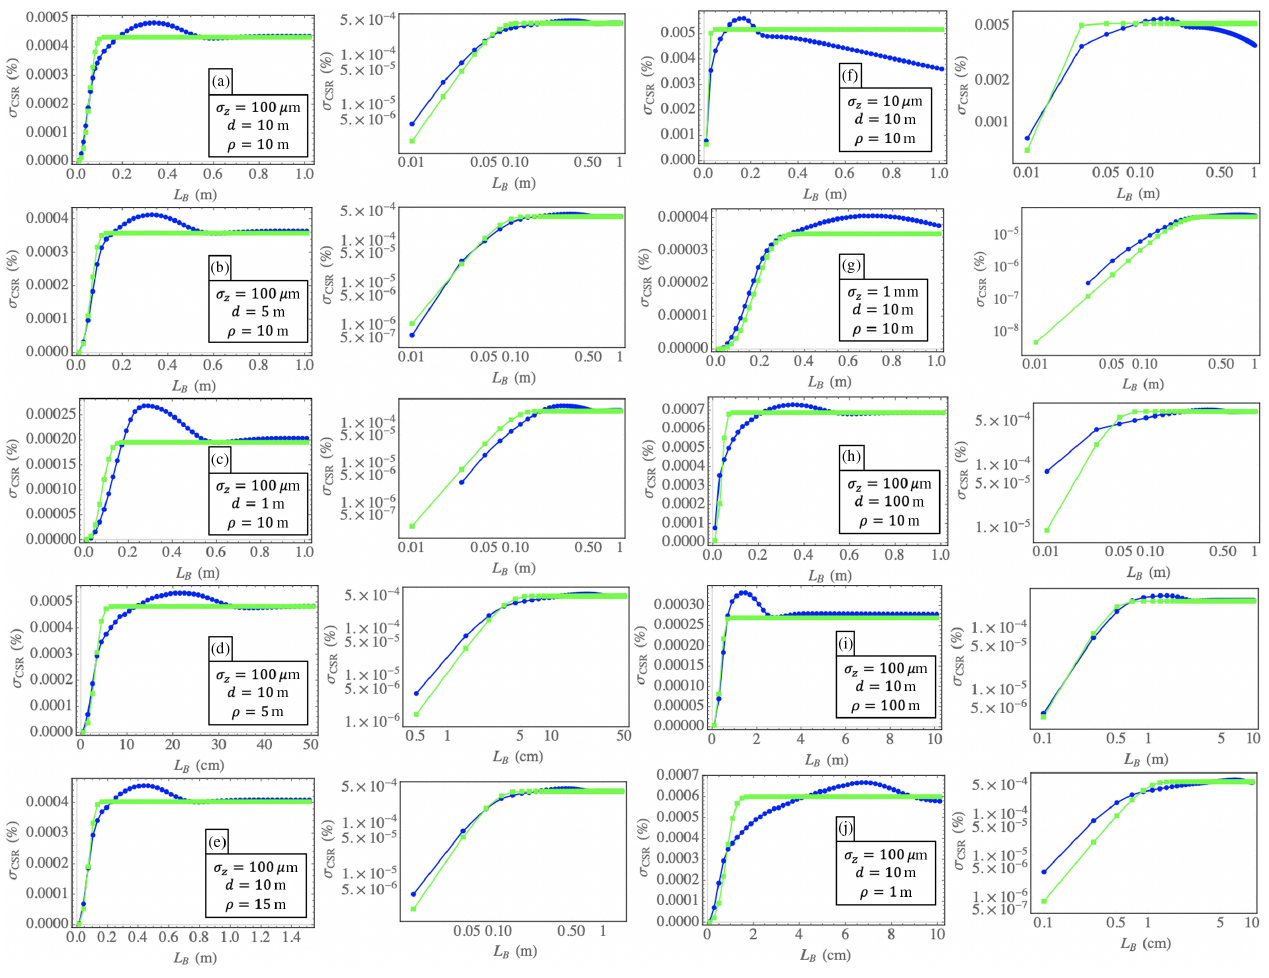
FIG. 8. The CSR rms energy spread (left column) and its Log-Log (right column) plots of an electron beam traversing the subsequent drift space of a bending magnet using ELEGANT (blue marker) and Eq. (27) (green marker) while varying the bending length, L B , for various bend radii, drift lengths, and bunch lengths.